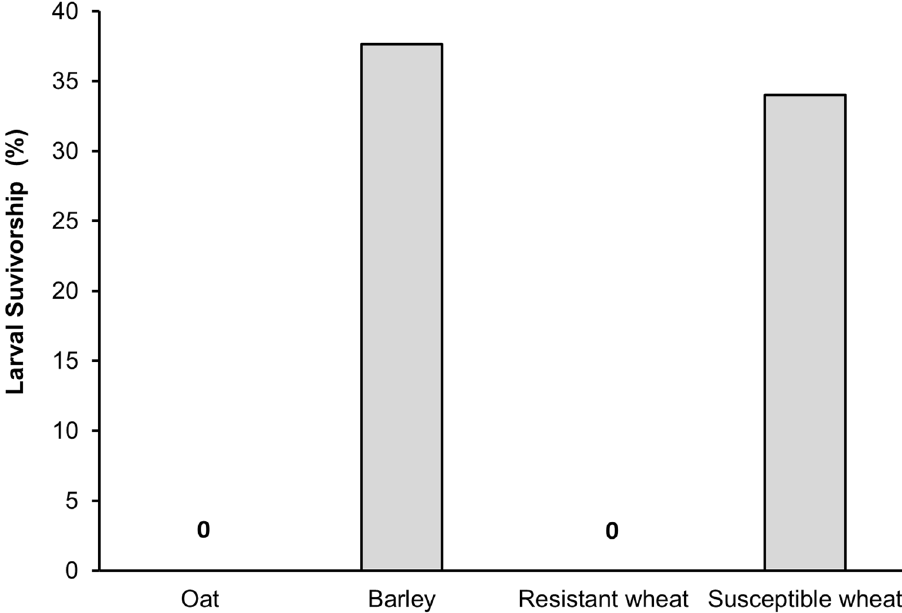
Figure 3. Survivorship of larvae on each host plant treatment in no-choice tests. None of the larvae made it to the pupal stage on either oat or resistant wheat host. Oat (cv. Cayuse); Barley (cv. Champion); Resistant wheat (cv. Hollis); Susceptible wheat (cv. Alturas).